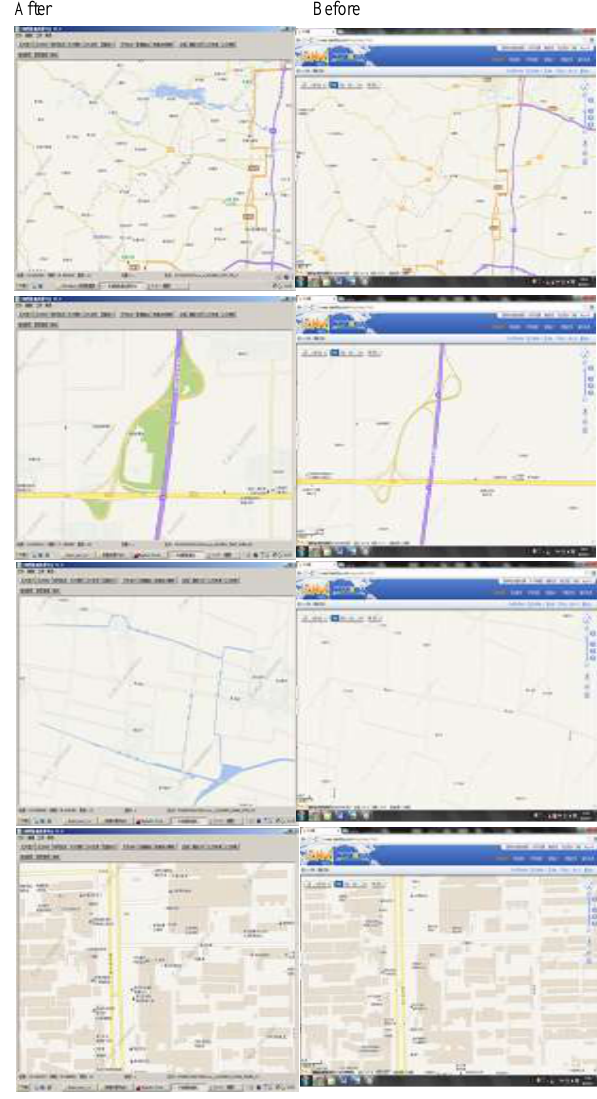
Figure 3 Experiment